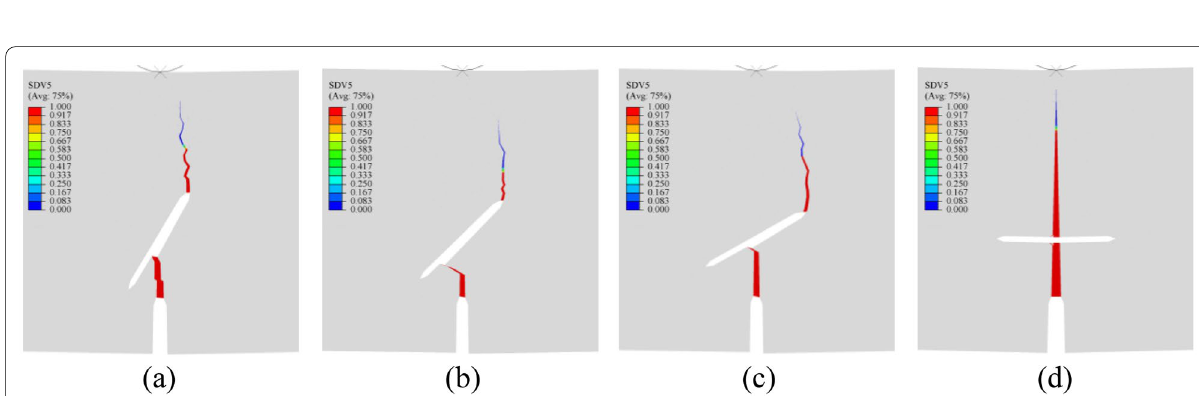
Fig. 16 SDV5 nephograms of the models with ( a ) θ